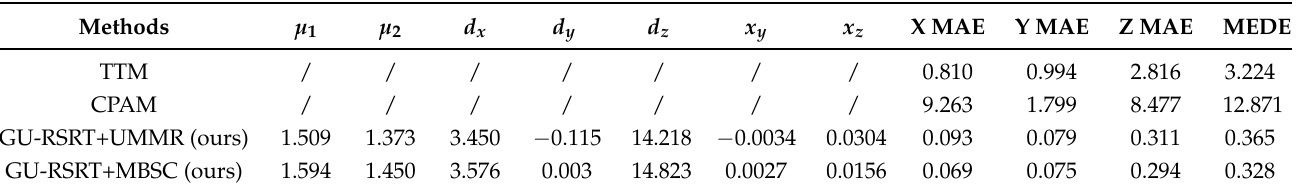
Table 7. The calibration results and 3D reconstruction errors of GelStereo BioTip sensor. The unit